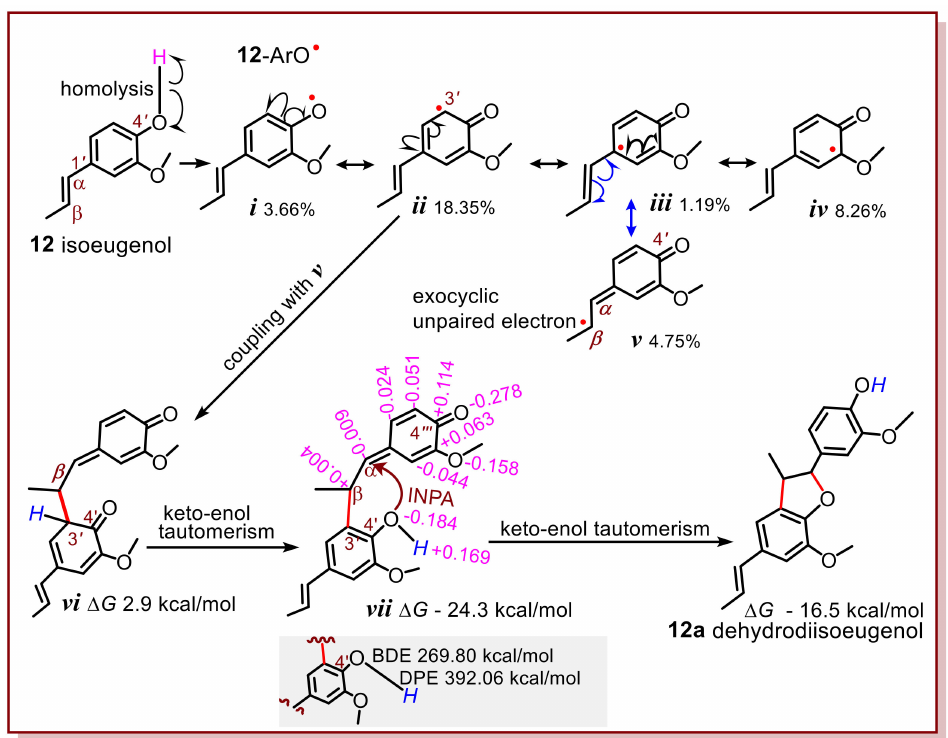
Figure 2. The possible process from isoeugenol ( 12 ) to dehydrodiisoeugenol ( 12a ) based on computa- tional chemistry. Documental 12a has no absolute configuration. The pink numbers represent the Hirshfeld charges of atoms. The percentages under i – v refer to the weights of the resonance formula in the natural resonance theory (NRT) analysis. ∆ G means the change in Gibbs free energy. ICA, intramolecular conjugate addition; BDE, bond disassociation enthalpy; DPE, deprotonation enthalpy. The computational details were shown in Supplementary File